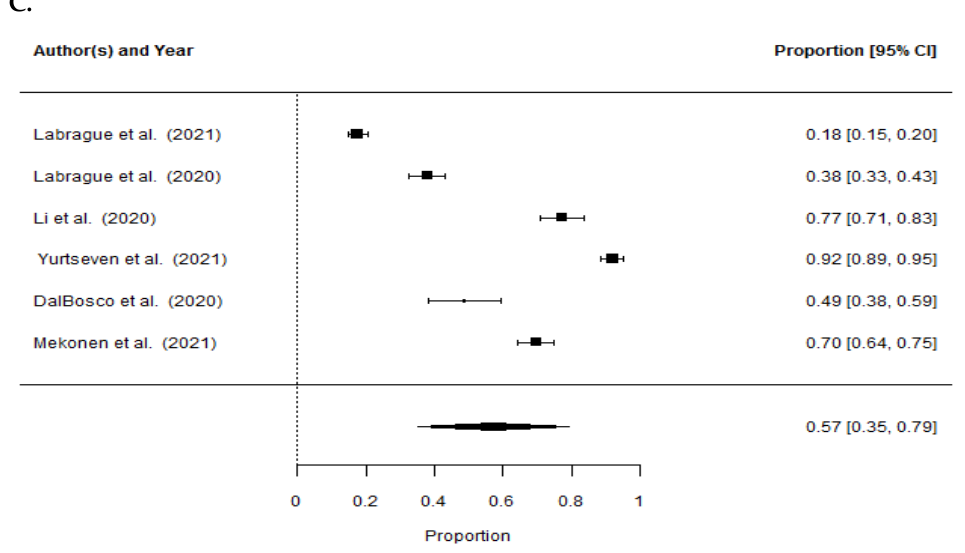
Figure 3. Forest plot for the prevalence of anxiety among nurses: ( A ) overall result; ( B ) assessment scale GAD-7; ( C ) assessment scale SAS; ( D ) remaining assessment scales, excluding GAD-7 and SAS.